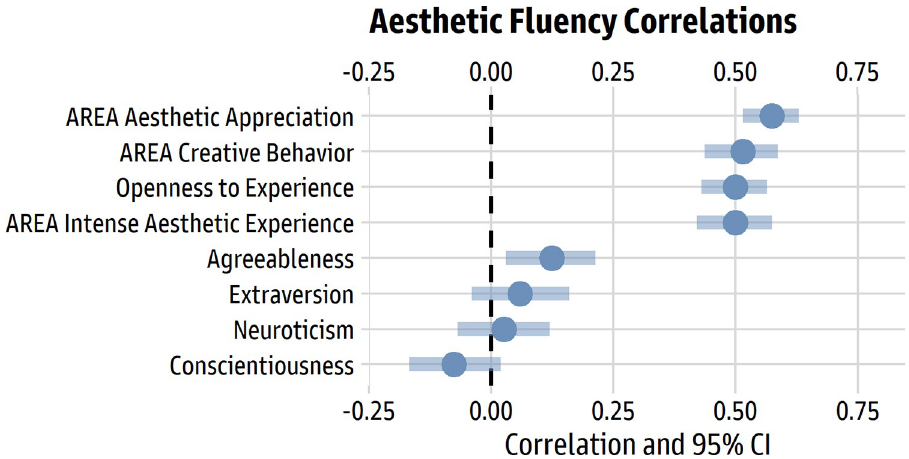
Fig 8. Pearson correlations for the revised Aesthetic Fluency Scale with big 5 traits and AReA subscales. The dots represent the Pearson r correlation value; the bars represent the 95% confidence interval around r